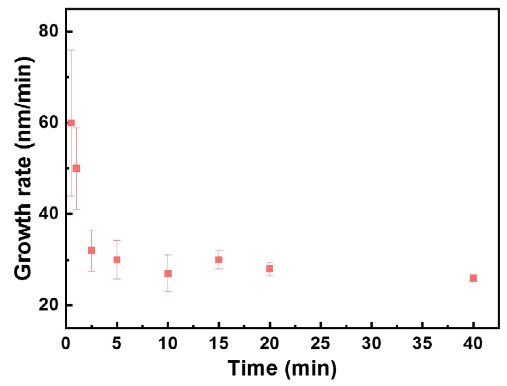
Figure 1. Deposition rate as a function of deposition time.